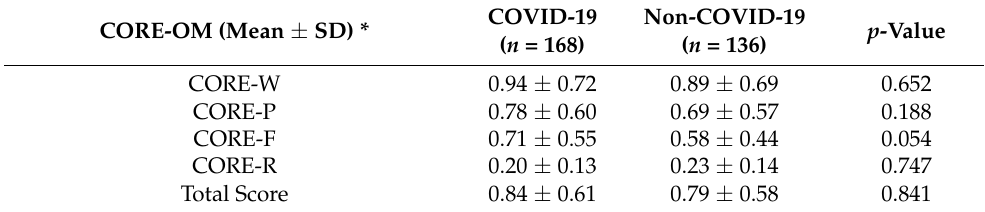
Table 5. The CORE-OM results between COVID-19 positive and negative pregnant women.